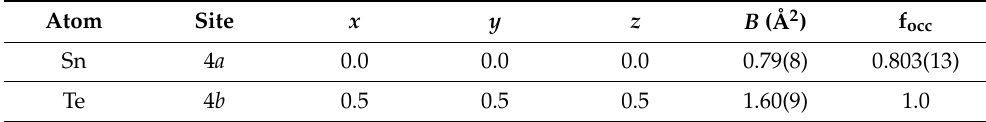
Table 1. Main structural parameters after the Rietveld refinement from NPD data at RT for SnTe in the cubic ( Fm-3m ) phase; a = 6.3212(1) Å.